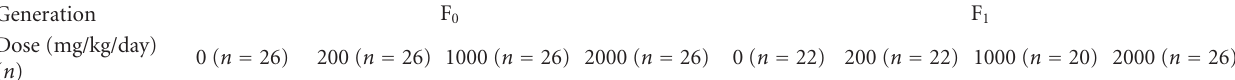
Table 4: Organ weight changes in male and female breeding Sprague-Dawley rats in the F 0 and F 1 generations of the two-generation rat study.